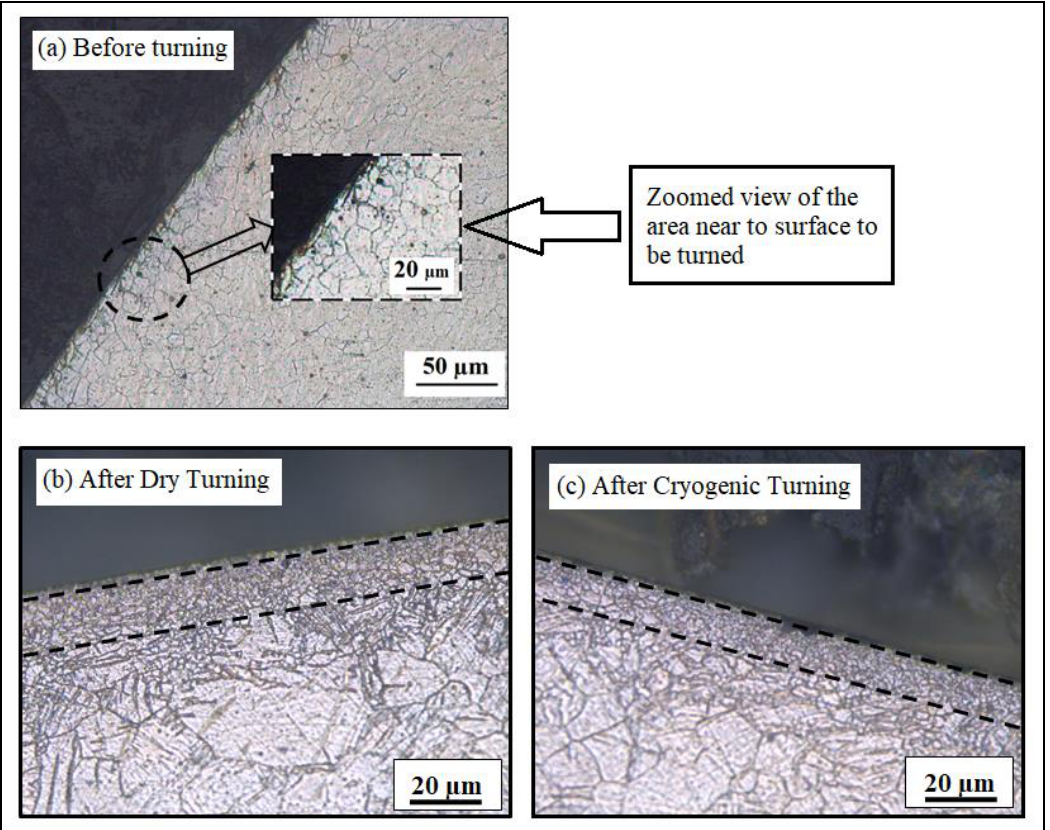
Figure 7. Micro-structures of the samples ( a ) before turning, ( b ) after dry turning and ( c ) after cryogenic turning. The micro-structures of the samples after turning operations (dry and cryogenic) at Vc = 150 m/min, f = 0.14 mm/rev and d = 0.2 mm are shown in Figure 7. It can be seen that grain refinement occurred after the turning operation in both environments. Especially near the turned surface, a grain refinement layer was observed, with a very small grain size compared to the other part of the sample. In addition to strain hardening, this grain